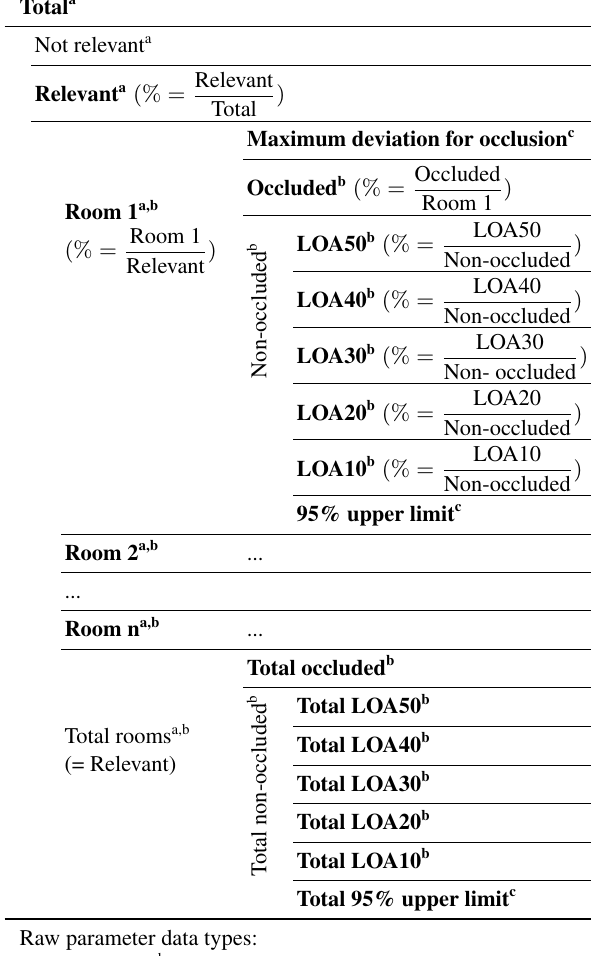
Table 3. Calculated quality assessment parameters of a checked BIM object with parts located in n rooms. For every parameter (except ‘Total’, ‘Maximum deviation for occlusion’ and ‘95% upper limit’) a percentage value can be calculated. The parameters indicated in bold are added as percentage parameters to the BIM object, except ‘Total’ (area), ‘Maximum deviation for occlusion’(distance) and ‘95% upper limit’ (distance).